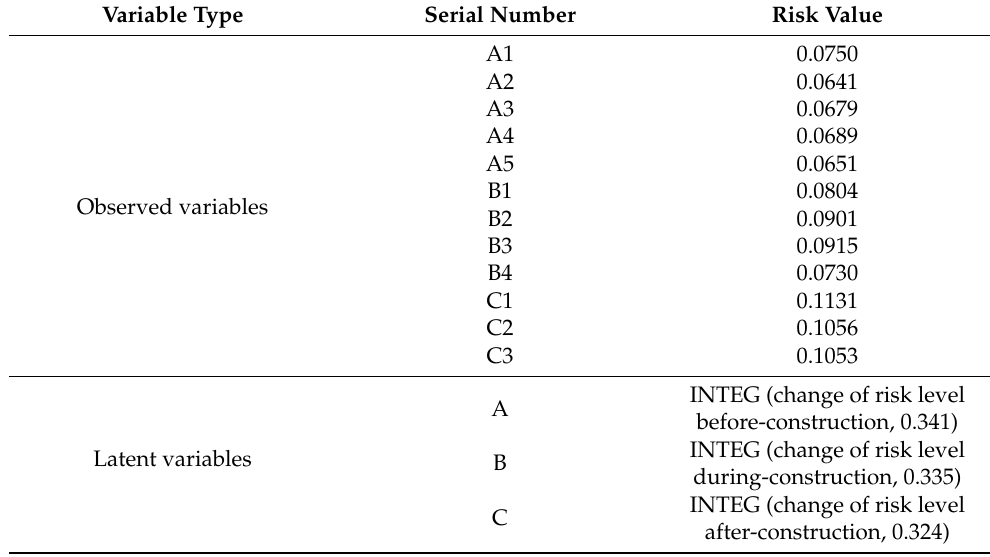
Table 3. Variable value and expression.